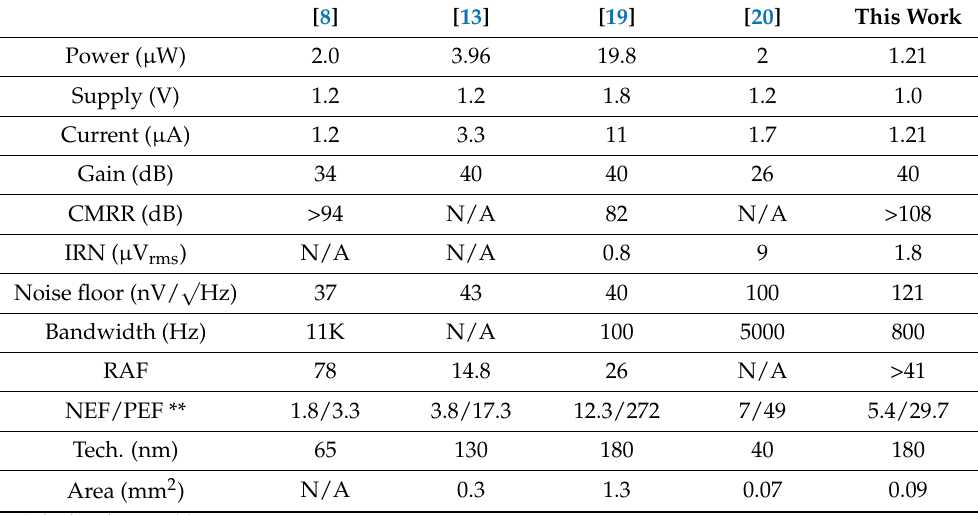
Table 3. Performance summary and